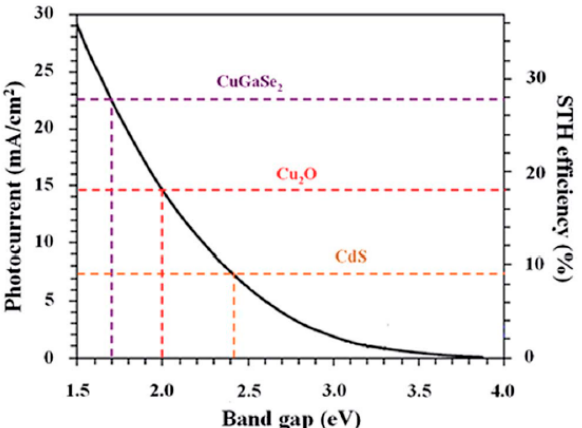
Figure 18. Dependence of the cathodic photocurrent density (left Y ‐ axis), and overall conversion efficiency for the PEC mediated process of solar energy transformation into molecular hydrogen (STH, right Y ‐ axis) on the value of energy bandgap of the photoelectroactive cathode. Reprinted with permission from reference [119].